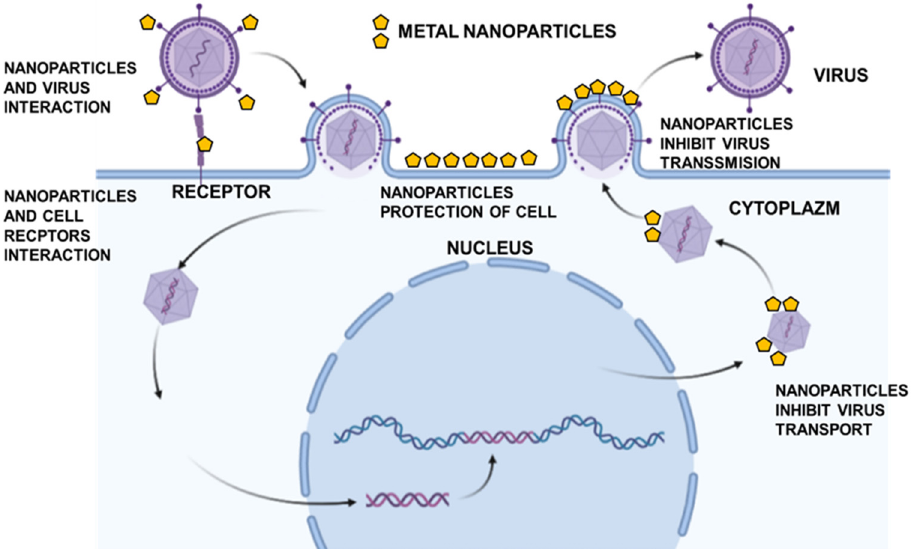
Figure 1. Potential antiviral mechanisms by metal nanoparticles: interaction with cell receptors, interaction with viral particles, inhibition of viral cell-to-cell spreading, and inhibition of virus transport. Based on our own studies, created in BioRender.